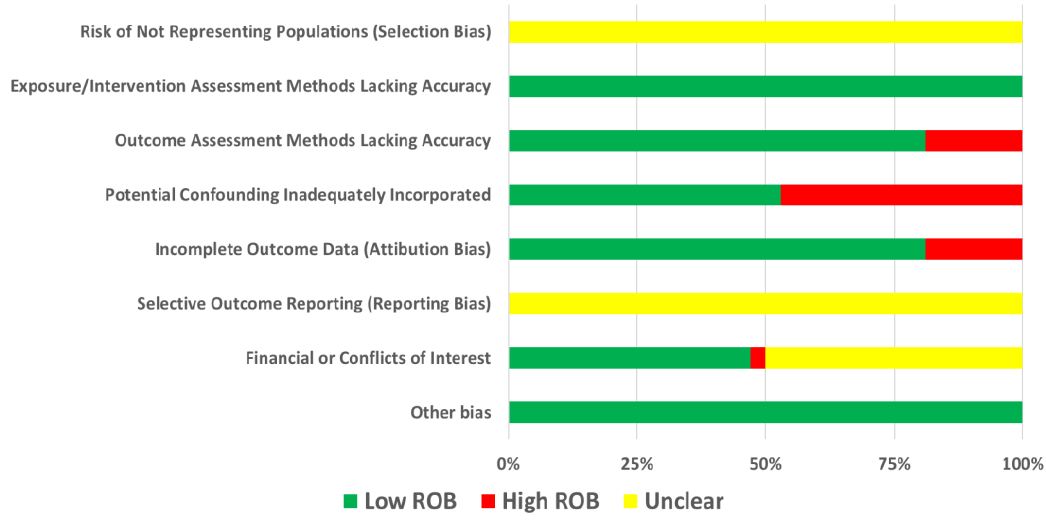
Figure 5. Risk of bias graph. ROB = Risk of bias.